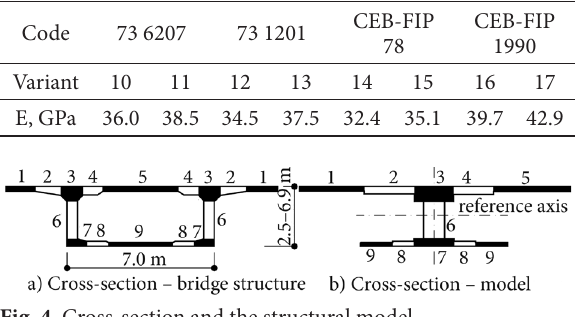
fig. 4. Cross-section and the structural model